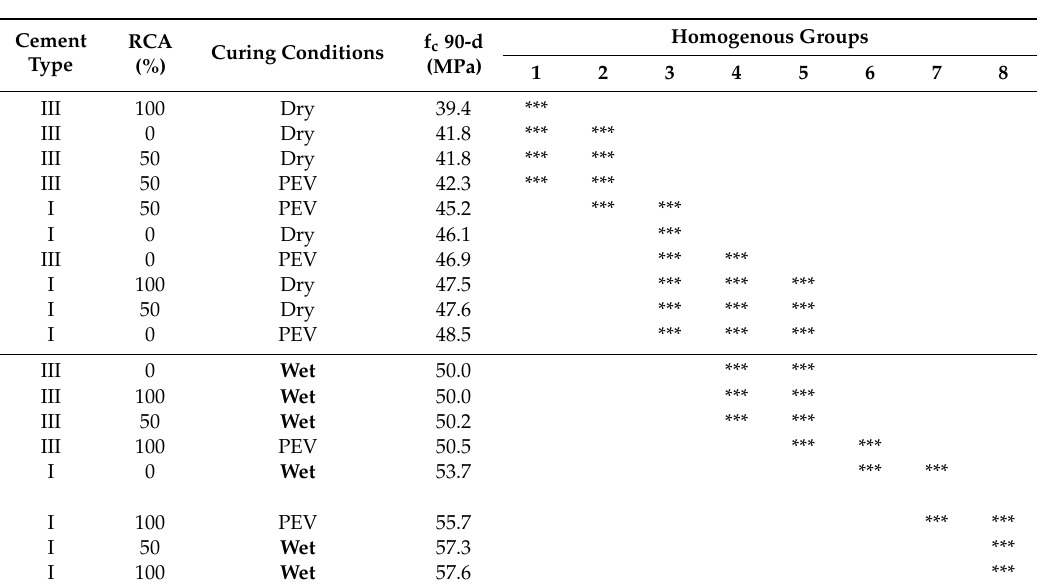
Figure 5. Compressive strength increase between 28 and 90 days. Table 6. Tukey’s test results for 90-day compressive strength (f c 90-d) of RAC